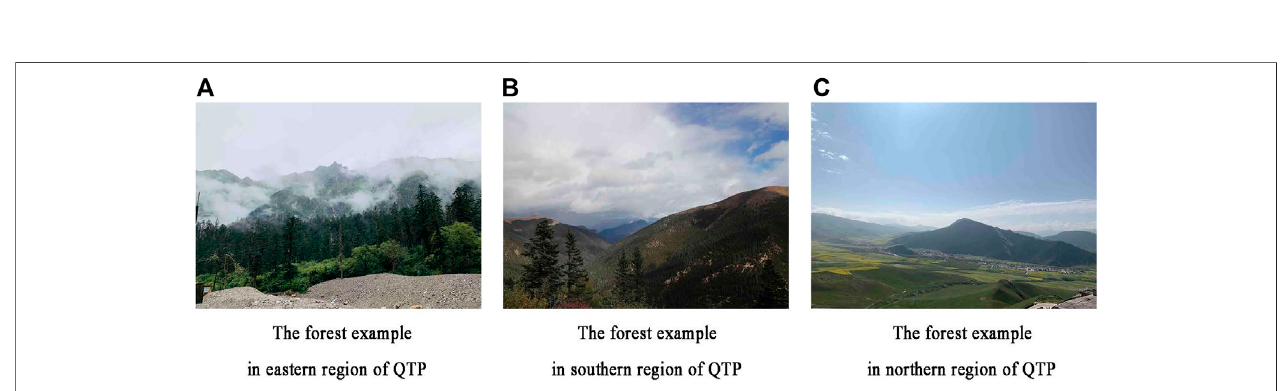
FIGURE 2 | (A – C) Forest examples in the eastern, southern, and northern regions of QTP.